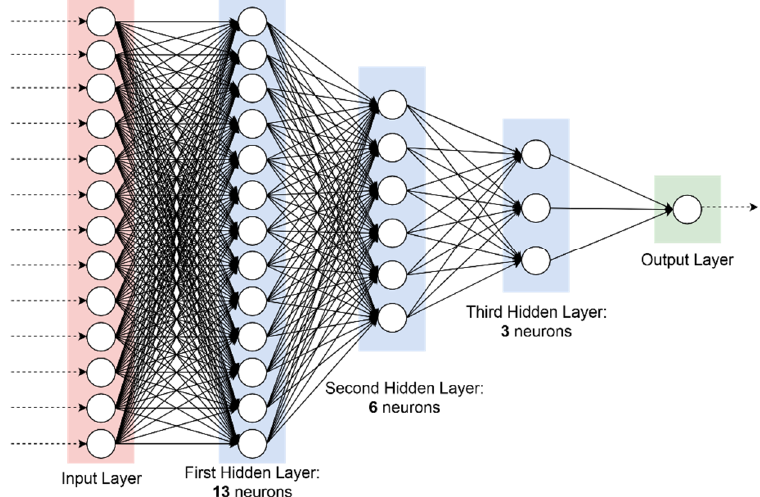
Figure 11. Architecture of the multilayer perceptron.